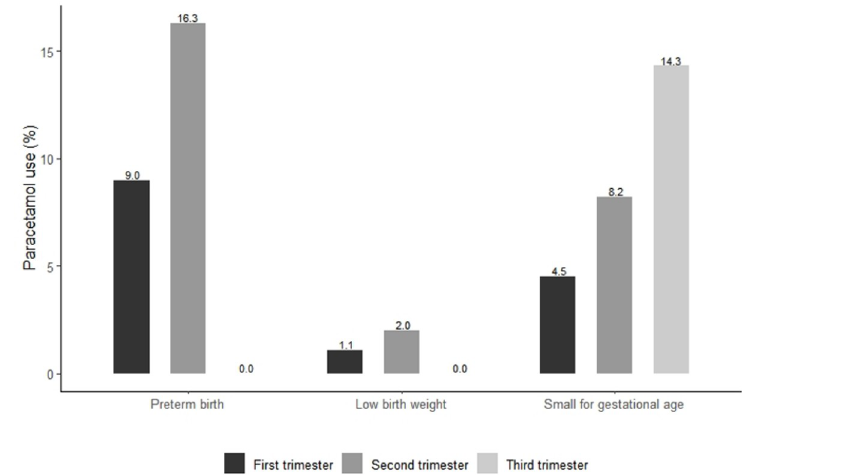
Fig 1. Paracetamol use according to trimester of exposure and perinatal outcomes.